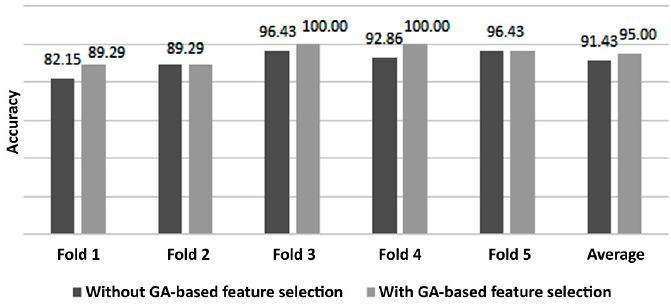
Figure 8. A 5-fold cross-validation of classifier accuracy with and without GA-based feature selection. GA: genetic algorithm.